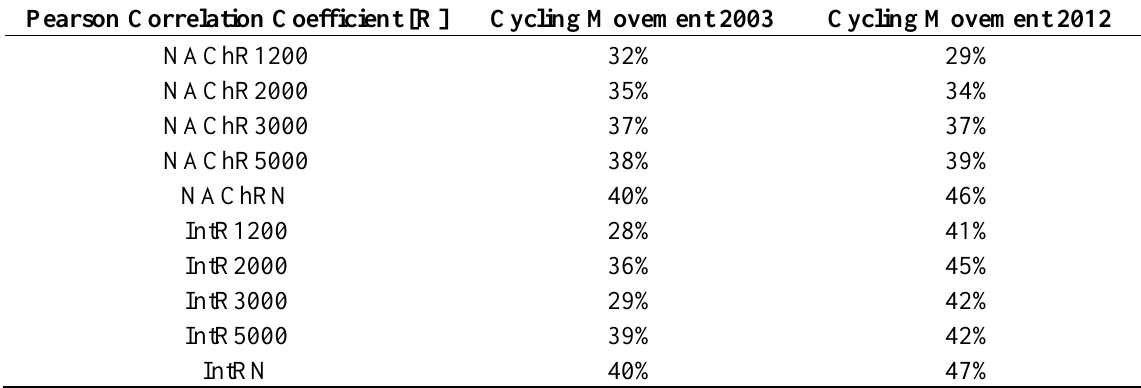
Table 4. Pearson correlation coefficient between average cyclist movement in 2003 and 2012 across different accessibility measure.